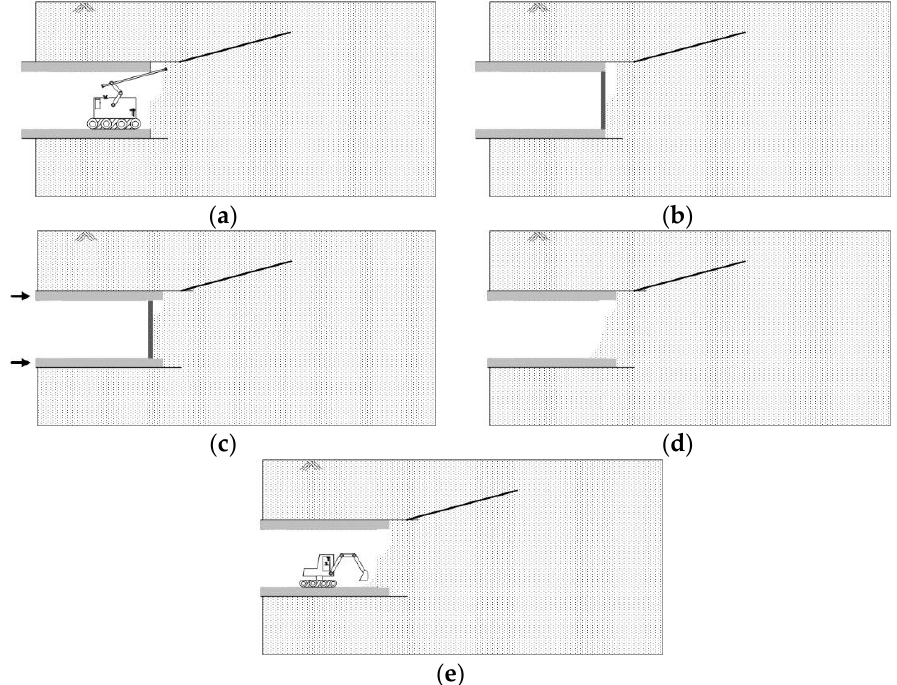
Figure 2. The step of tunnel construction in the non-open-cut method using small steel pipe piles: ( a ) installation of the forepoling using small steel pipe piles. ( b ) Placing the pressure panel at the tunnel face. ( c ) Propulsion of the precast structure (Stage 2). ( d ) Pulling back the pressure panel (Stage 1). ( e ) Excavation of the tunnel face using excavator.